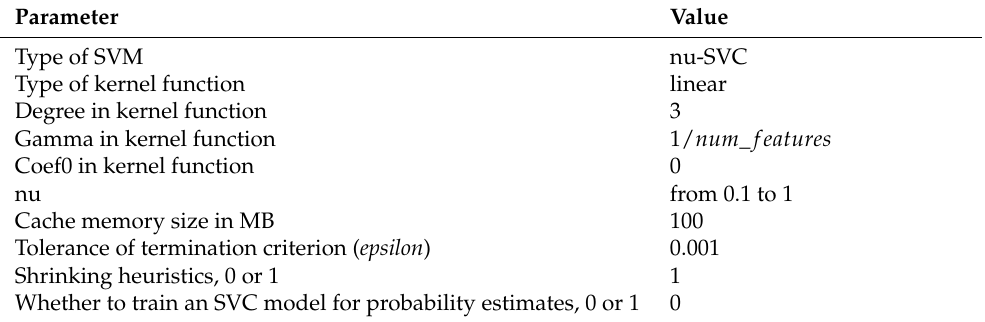
Table A3. SVM parameters.